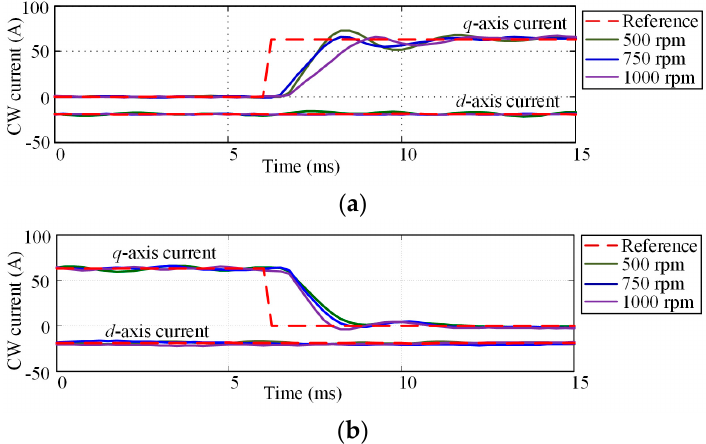
Figure 10. Dynamic responses of the CW current at different speeds (measure (solid); reference (dashed)). ( a ) i cq changes from 0 A to 63 A; ( b ) i cq decreases from 63 A to 0 A.